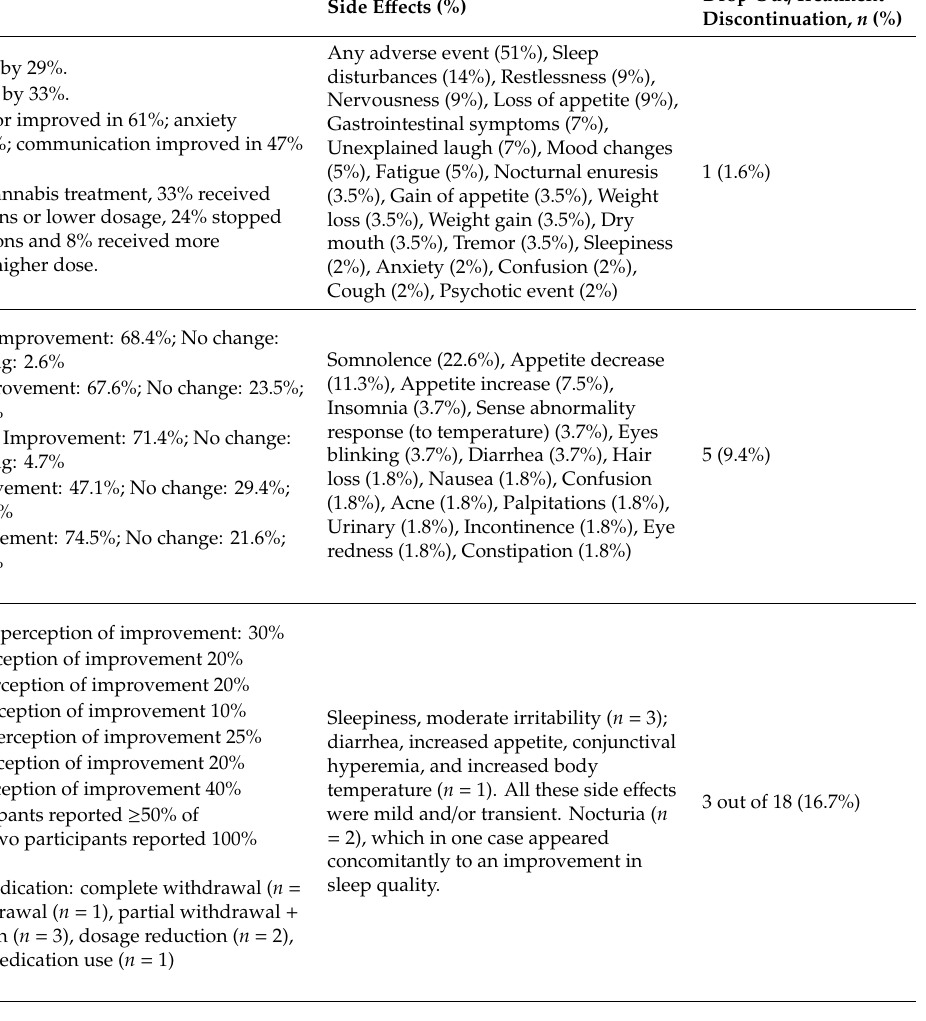
Table 2. E ffi cacy and safety of cannabinoids in people with autism spectrum disorder (ASD). Results Side E ff ects (%)